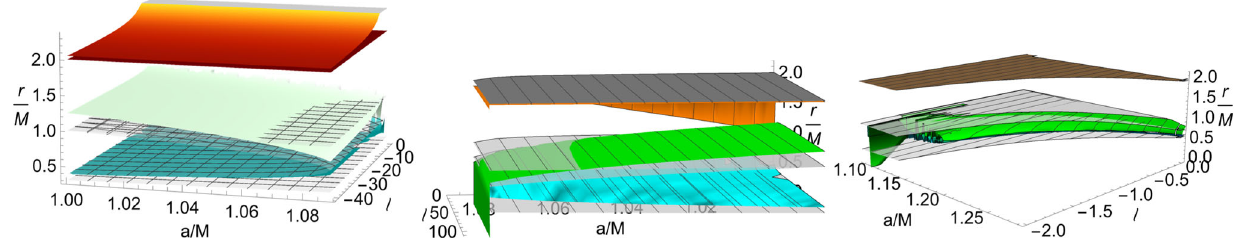
Fig. 21 Analysis of the outer edge r out of the tori orbiting NSs with are defined in Table 2. Left panel: counter-rotating tori. Note the inver- sion radius is always out of the ergoregion, the outer edge is inside spins a ∈] M , a 2 ] with centers and cusps bounded by r ± and r ± δ . Panels 0 the ergoregion crossing, for some ( a ,(cid:6)) , the plane r + show the cusped torus inner and outer edges and the inversion point r + (cid:2) co-rotating tori. The inversion radius is always inside the ergoregion. on the equatorial plane. There is r × < r out < r + (cid:2) . There is no solution Right panel: counter-rotating tori. The inversion radius is located out of r out = r + (cid:11) = 2 M ontheequatorialplane.Radius r + (cid:11) istheouterergosur- the face (gray-plane). Light-gray surfaces are r ± and r ± δ . Spins { a 0 , a 1 , a 2 } 0